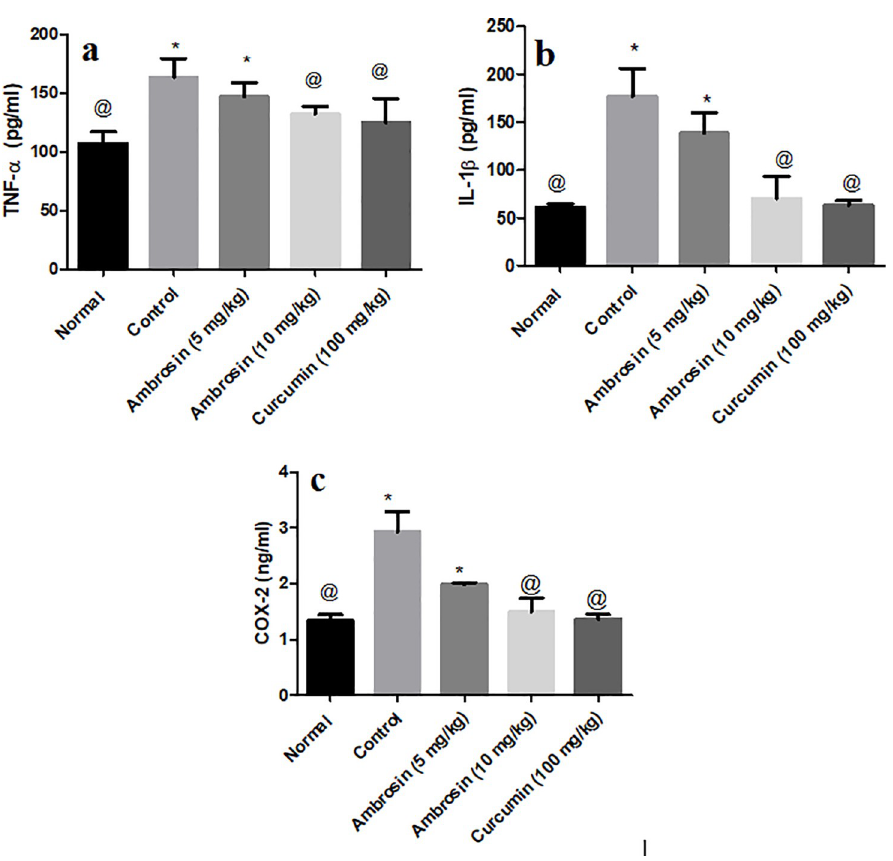
Fig 5. Curcumin and ambrosin alleviated neuroinflammation by inhibition of repression of pro-inflammatory cytokines, viz . , TNF- α (a), IL-1 β and enzymes, viz ., COX-2 (c). Data represented mean ± SEM (n = 6). Statistical analysis was performed using one-way ANOVA followed by Tukey‘s multiple comparison test. � Significantly different from normal group at P < 0.05. @ Significantly different from control group at P < 0.05.